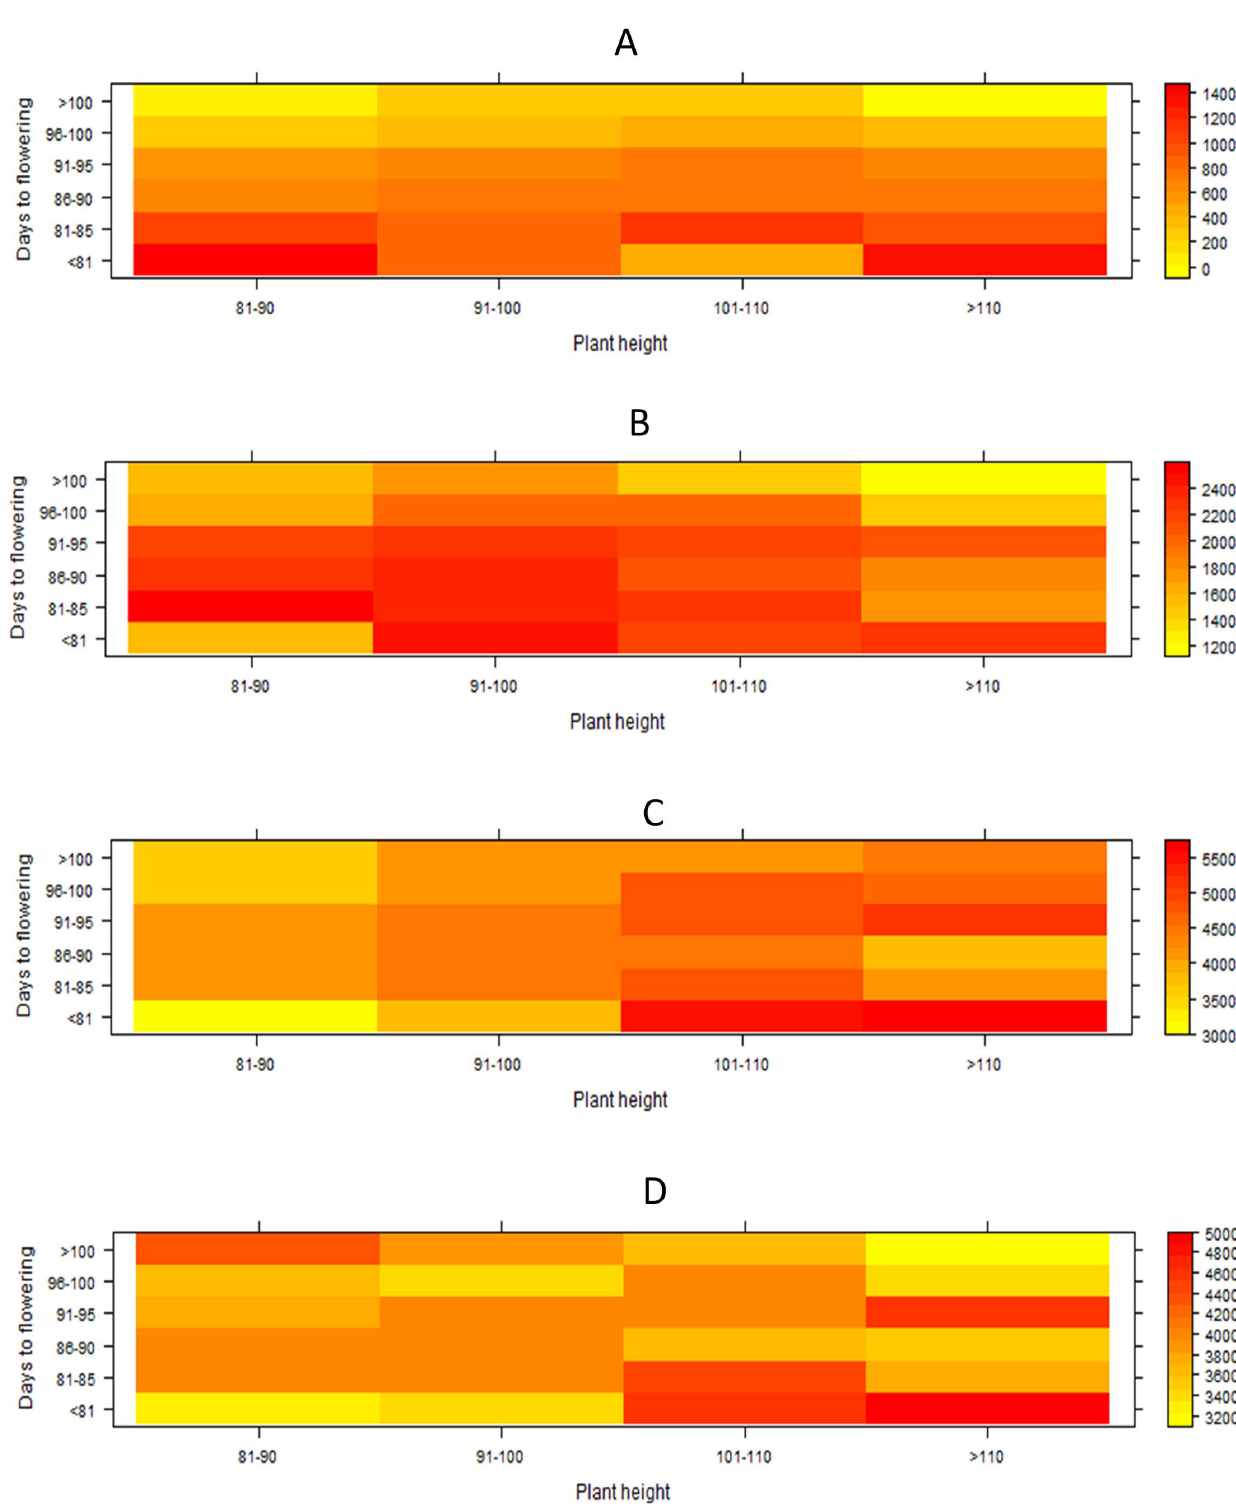
Figure 3. Heat maps showing the effect of DTF and PH on yield performance of lines under (A) lowland severe stress (LSS), (B) lowland moderate stress (LMS), (C) lowland non-stress (LNS I) and (D) LNS II conditions. Increasing intensity of colors from yellow to orange indicates increasing yield levels while white color shows the unavailable PH class.